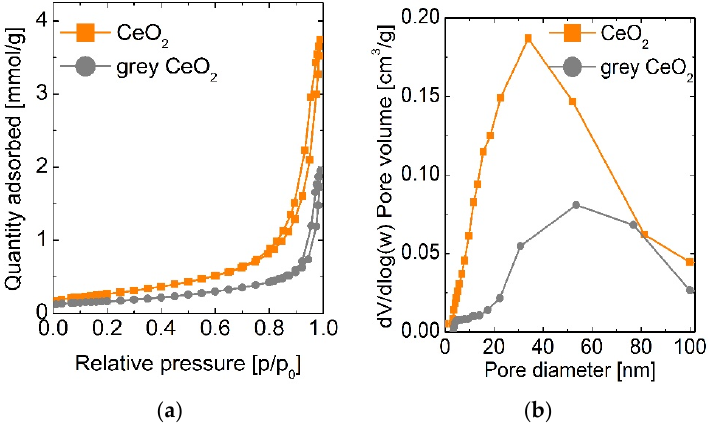
Figure 3. ( a ) N 2 adsorption–desorption isotherms of the CeO 2 samples; ( b ) pore size distribution curve of the analyzed samples evaluated by means of the Barrett, Joyner and Halenda (BJH) method.